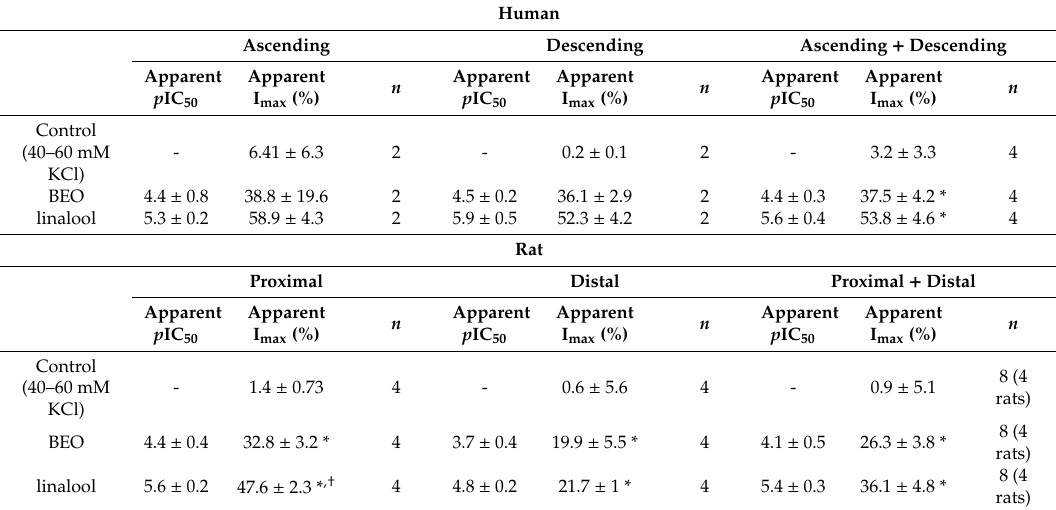
Table 2. Apparent p IC 50 and apparent I max for the inhibition of KCl-evoked contractions in human and rat